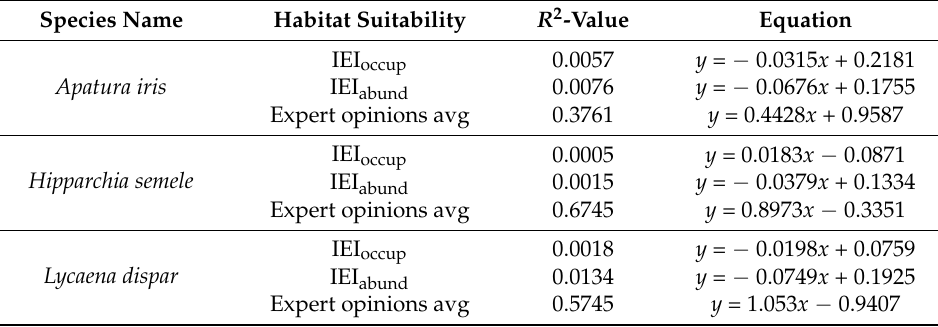
Table 2. Relationship between land cover permeability and suitability as rated by experts for all six species.